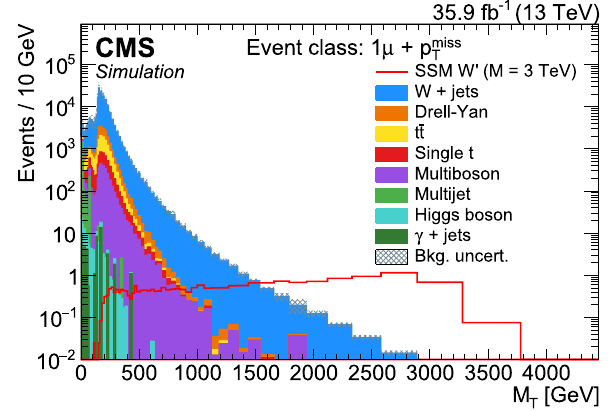
Fig. 4 Distribution of the transverse mass for the 1 μ + p miss class with a hypothetical SSM W (cid:11) boson (with mass of 3 TeV) along with the SM